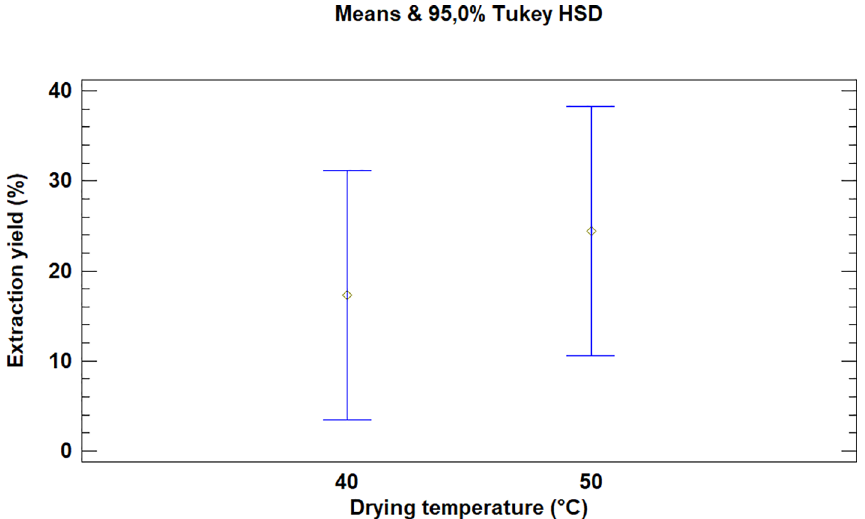
Figure 3.Comparison ofTukey's meansforyields of Bidenspilosa L. extractsaccording todrying temperature.